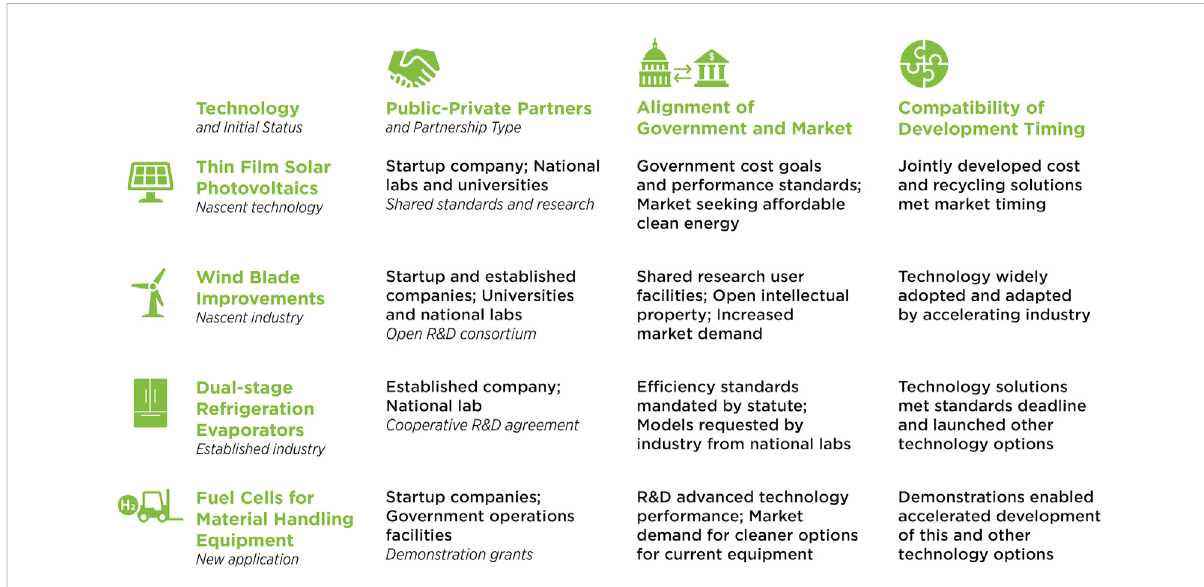
FIGURE 8 Graphical summary of common approaches and key distinctions across four case studies of fi rst